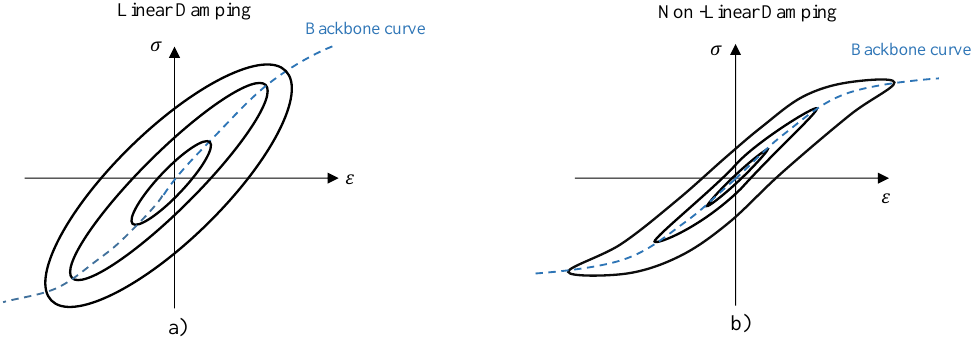
Figure 1. Schematic of a hysteresis cycle for materials with: ( a ) linear and ( b ) nonlinear damping.